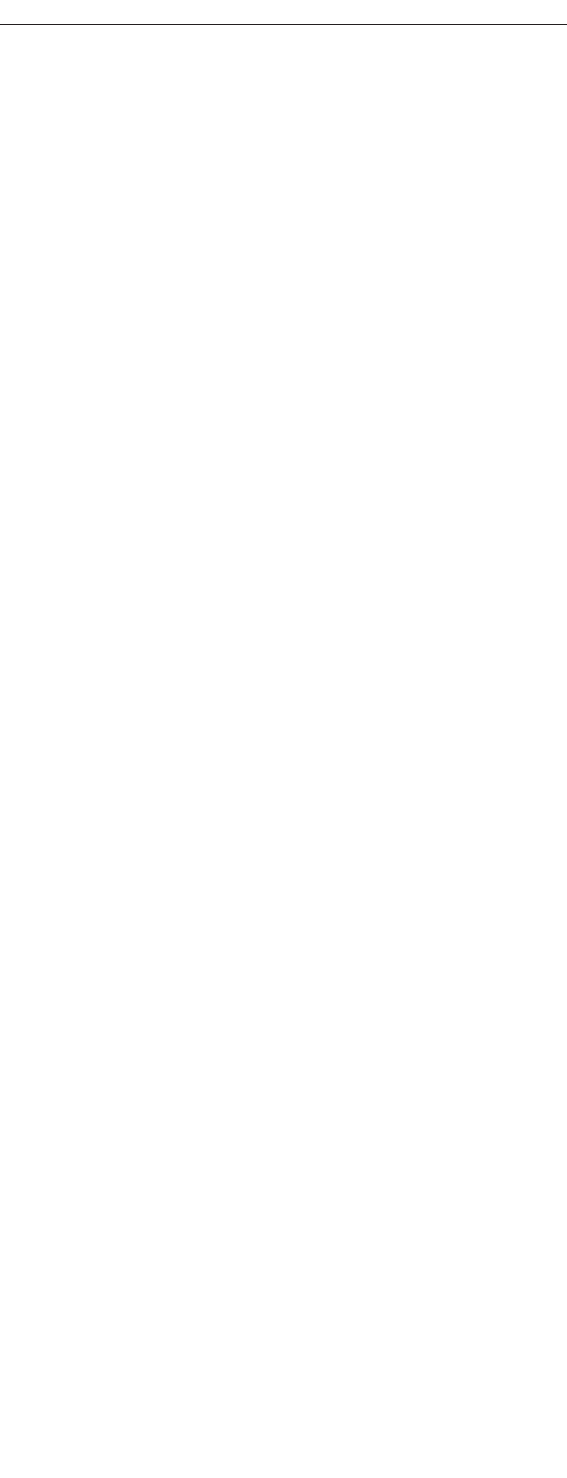
12 South African Journal of Science